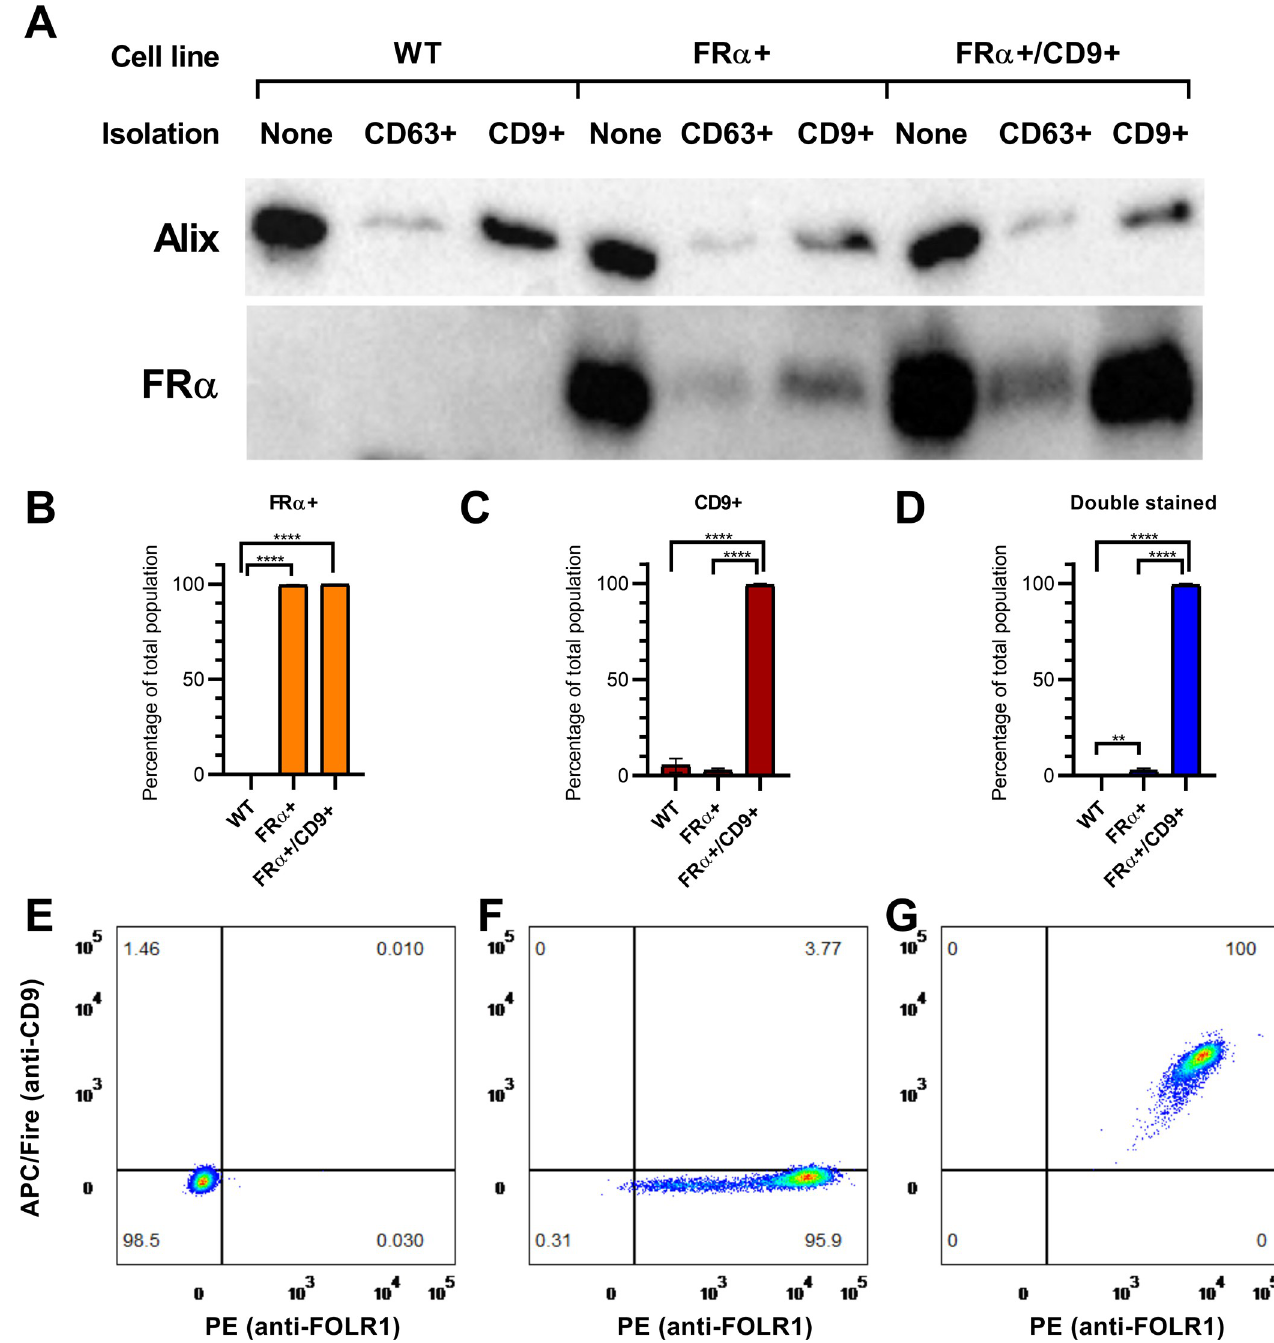
Fig 4. Detection of protein markers in EVs. (A) WB detection of FR α in EVs from WT, FR α + and FR α +/CD9+ cells after different isolation protocols. Alix was used as a control. For each cell line, 8 μ g proteins from EVs before purification with functionalized beads were loaded as reference. (B) Percentage of FR α + particles for each cell line after anti-CD9-beads purification, measured by flow cytometry. (C) Percentage of CD9+ particles after anti-CD9-beads purification, measured by flow cytometry. (D) Percentage of particles positive for both markers after anti-CD9-beads purification, measured by flow cytometry. (E) Example of flow cytometry of a EVs sample from WT cells after anti-CD9-beads purification. (F) Example of flow cytometry of a EVs sample from FR α + cells. (G) Example of flow cytometry of a EVs sample from FR α +/CD9+ cells. Data are represented as mean ± s.d. n = 3 for each line.